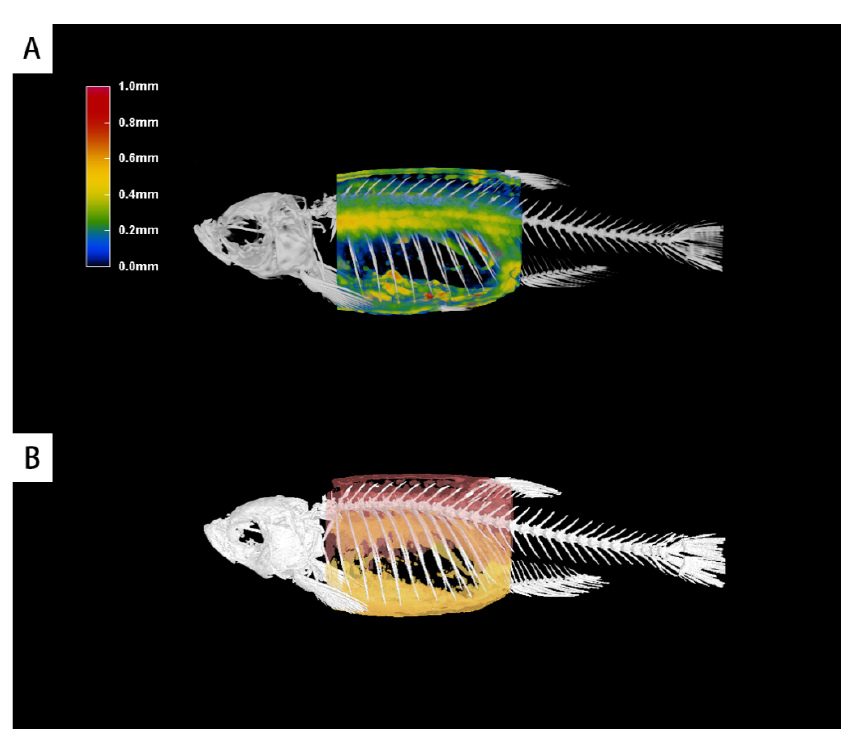
Figure 13. Distribution of abdominal adipose tissue thickness ( A ) and 3D surface rendering ( B ).